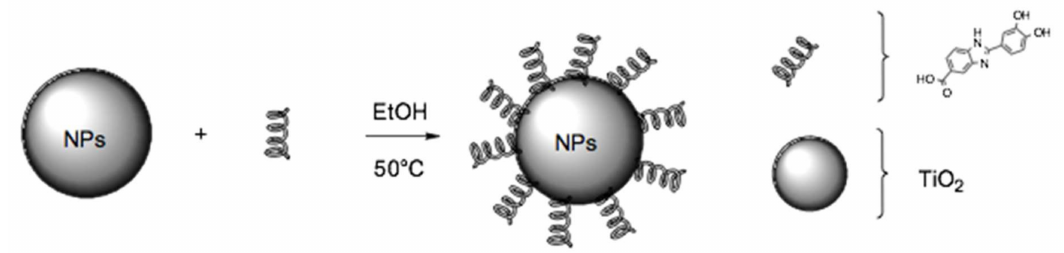
Figure 2. TiO 2 coating by Oxisol. The reaction was carried out in ethanol at 50 ◦ C for 24 h.